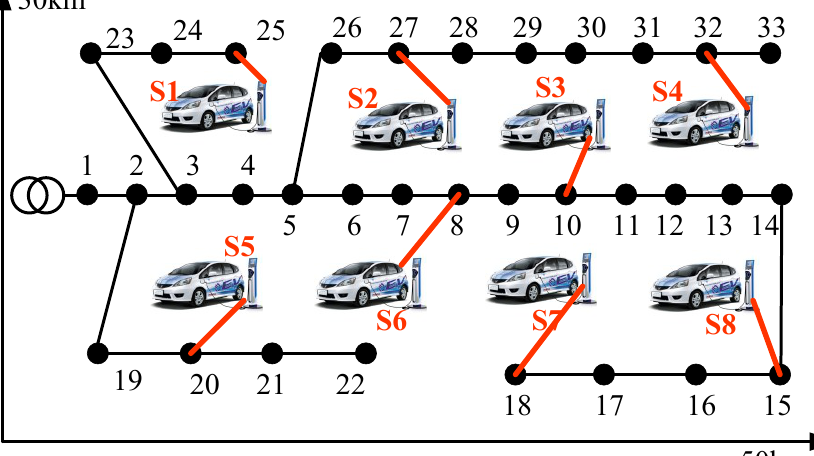
Figure 7. Case setting for